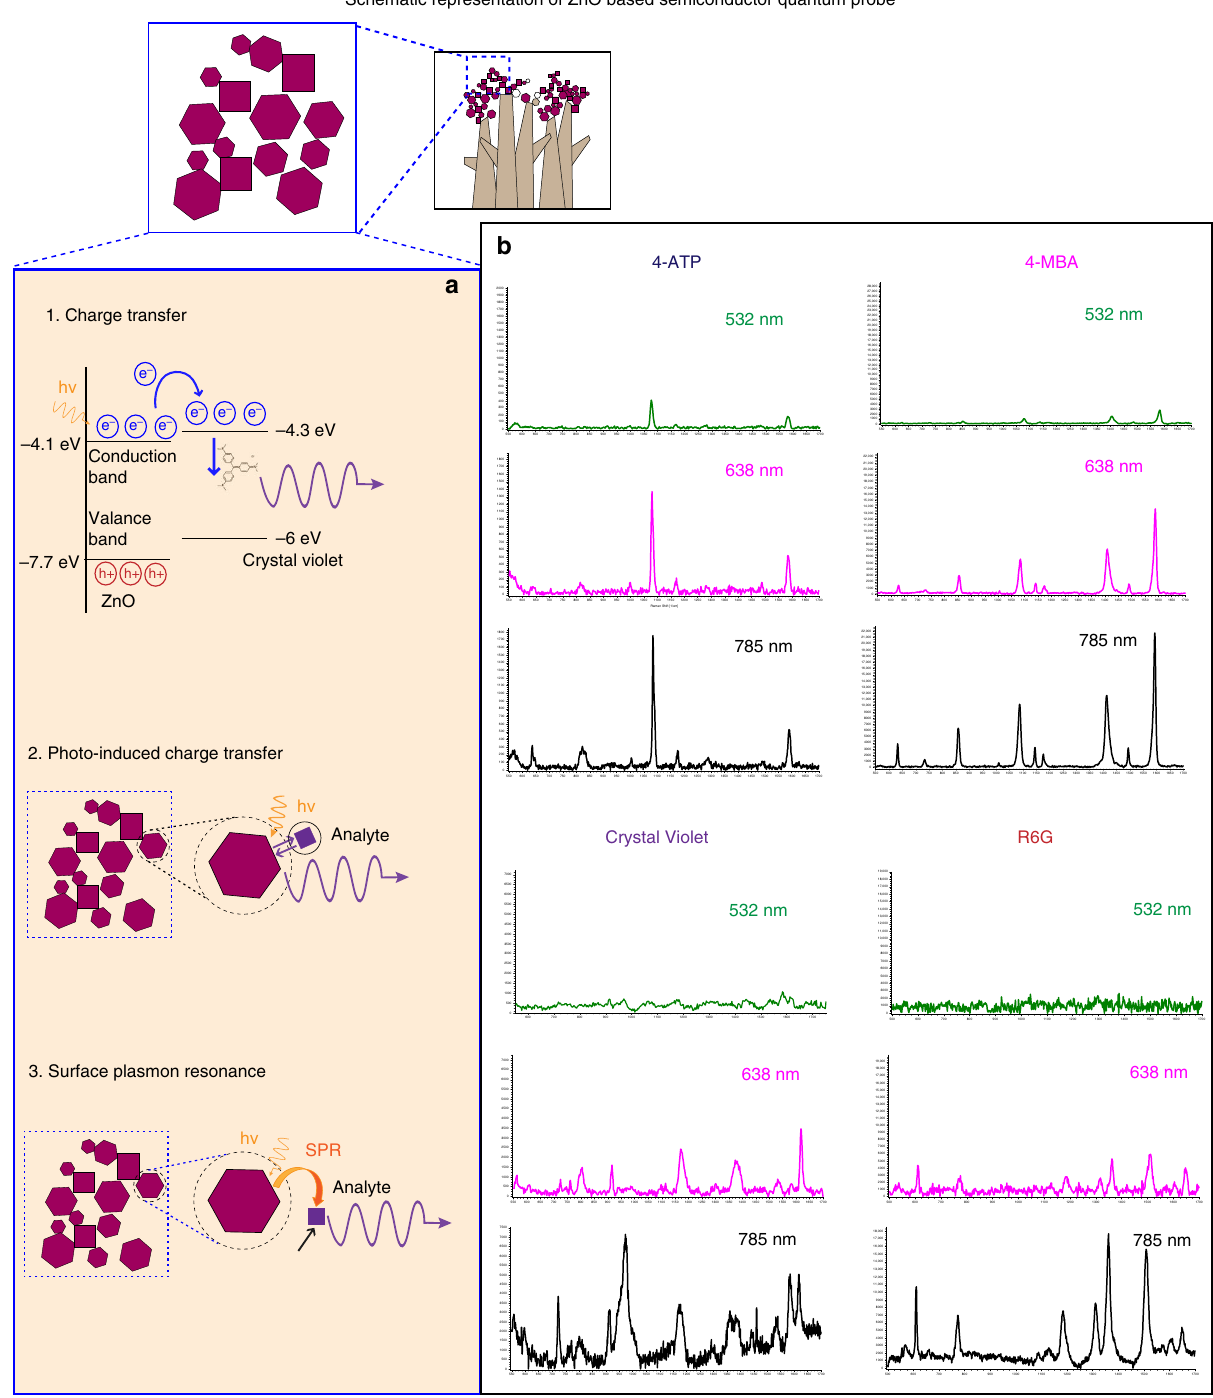
Fig. 3 The enhancement mechanism and wavelength-dependent SERS. a Enhancement was due to the co-existence of (1) charge transfer resonance, (2) photo-induced charged transfer from attenuated total re fl ection causing near fi eld interaction due to quantum size, and (3) surface plasmon resonance in a uni fi ed molecule – semiconductor quantum probe system. b The ZnO-based semiconductor quantum probe was able to demonstrate ability for SERS enhancement at multiple excitation wavelengths. The “ x ” axis of the spectra display Raman Shift (cm − 1 ) and “ y ” axis displays arbitrary units. The evidence of non-totally symmetric b2 modes reveal dominance of the charge transfer